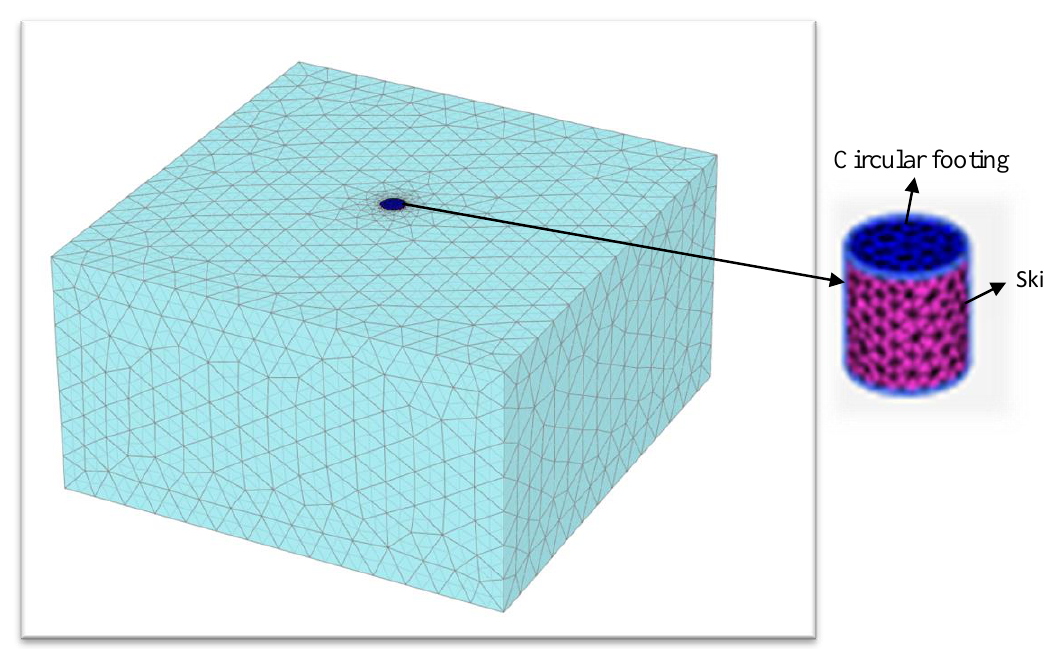
Fig. 1. Three-dimensional view of the model skirted Circular footing